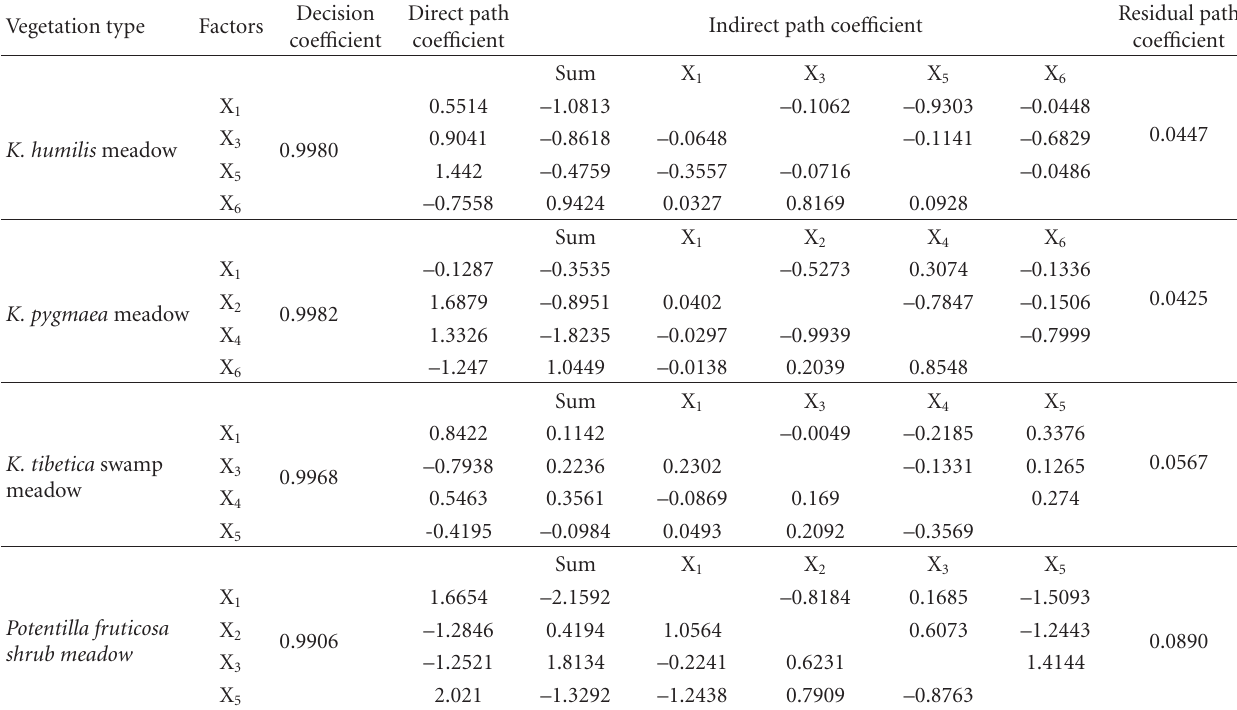
Table 4: Path analysis on CAB to soil C and soil enzyme